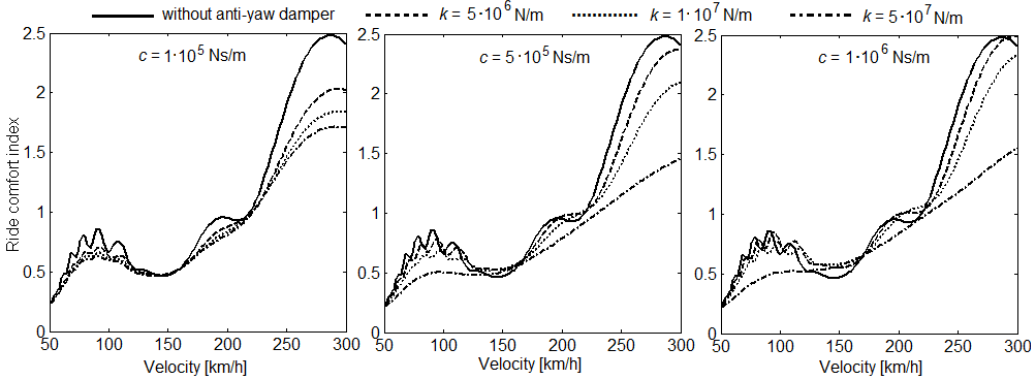
Figure 10. Influence of damping and stiffness of the anti-yaw damper upon the ride comfort index at the carbody center.